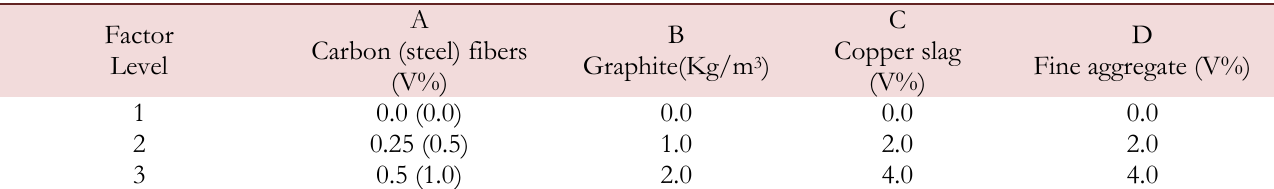
Table 1: Factors and levels.